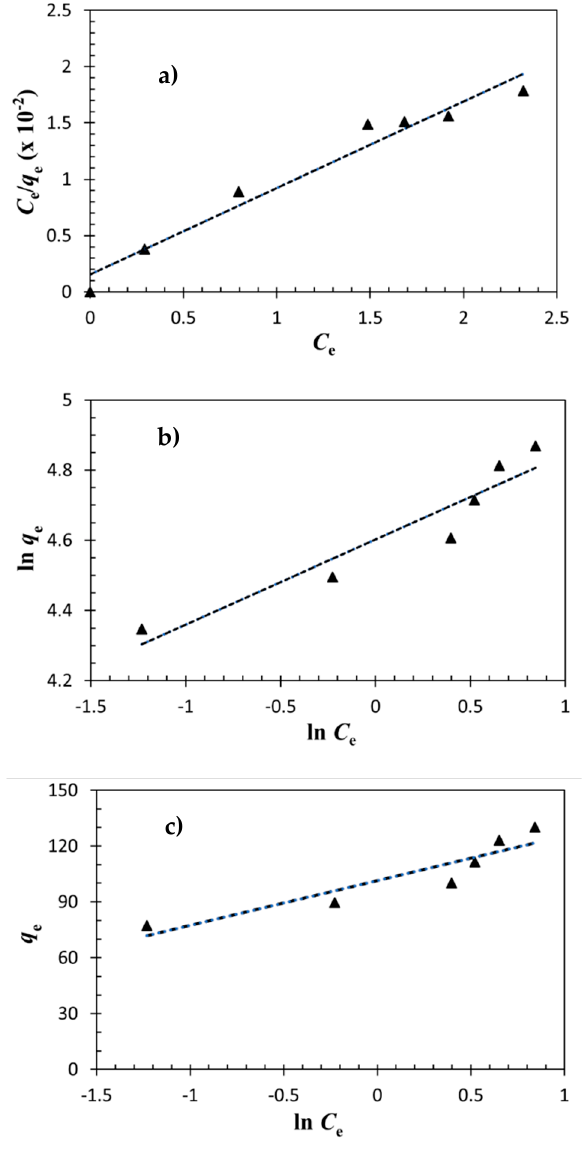
Figure 13. Adsorption isotherms of MB adsorption onto rGO ( a ) Langmuir, ( b ) Freundlich, and ( c ) Temkin models at 298 K. Table 2. Constant parameters and correlation coefficients calculated for different adsorption iso- therm models at different temperatures for MB adsorption on rGO.